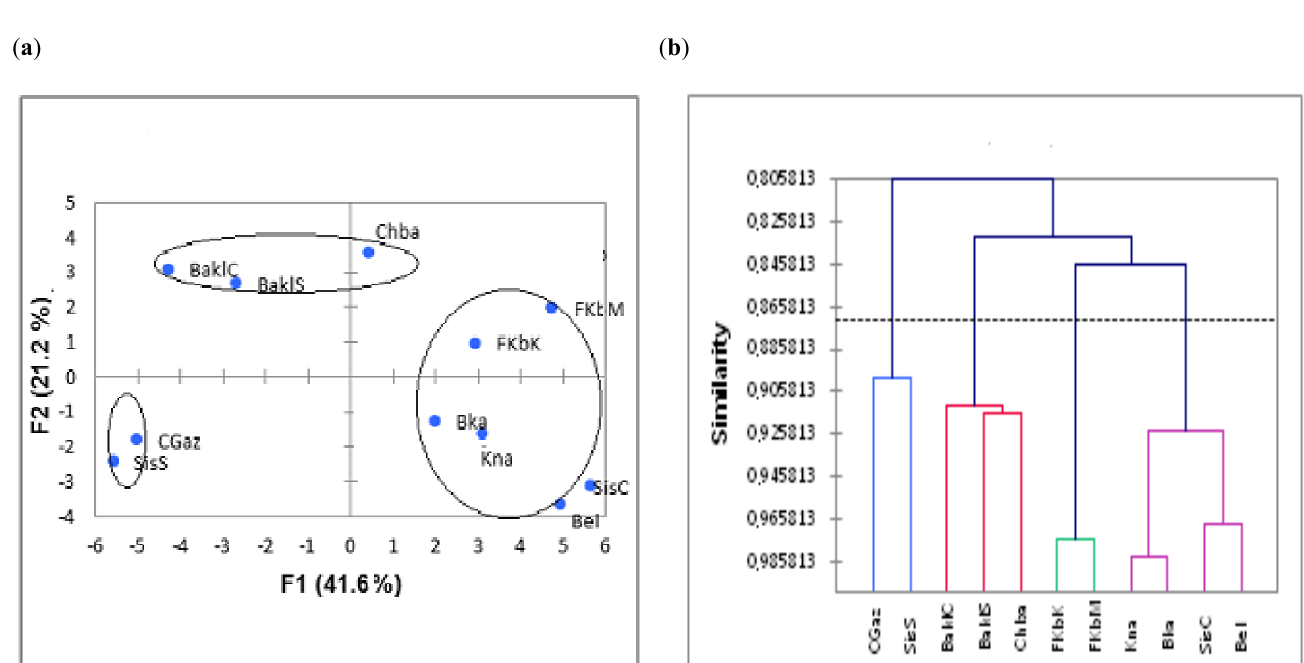
Figure 2. ( a ) Spatial distribution of the eleven Tunisian chili pepper accessions according to the first two PCA components based on the agro-morphological traits. ( b ) Dendrogram obtained from cluster analysis of the eleven Tunisian chili pepper accessions based on the analyzed quantitative and qualitative traits. ‘Baklouti Chébika’ (BaklC), ‘Beldi’ (Bel), ‘Chaabani’ (Chba), ‘Sisseb Chébika’ (SisC), ‘Bkalti’ (Bkaa), ‘Knaiss’ (Kna), ‘Baklouti Sbikha’ (BaklS), ‘Sisseb Sbikha’ (SisS), ‘Fort Menzeltemim’ (FkbM), ‘Fort de korba’ (FkbK), ‘Corne de Gazelle’ (CGaz).